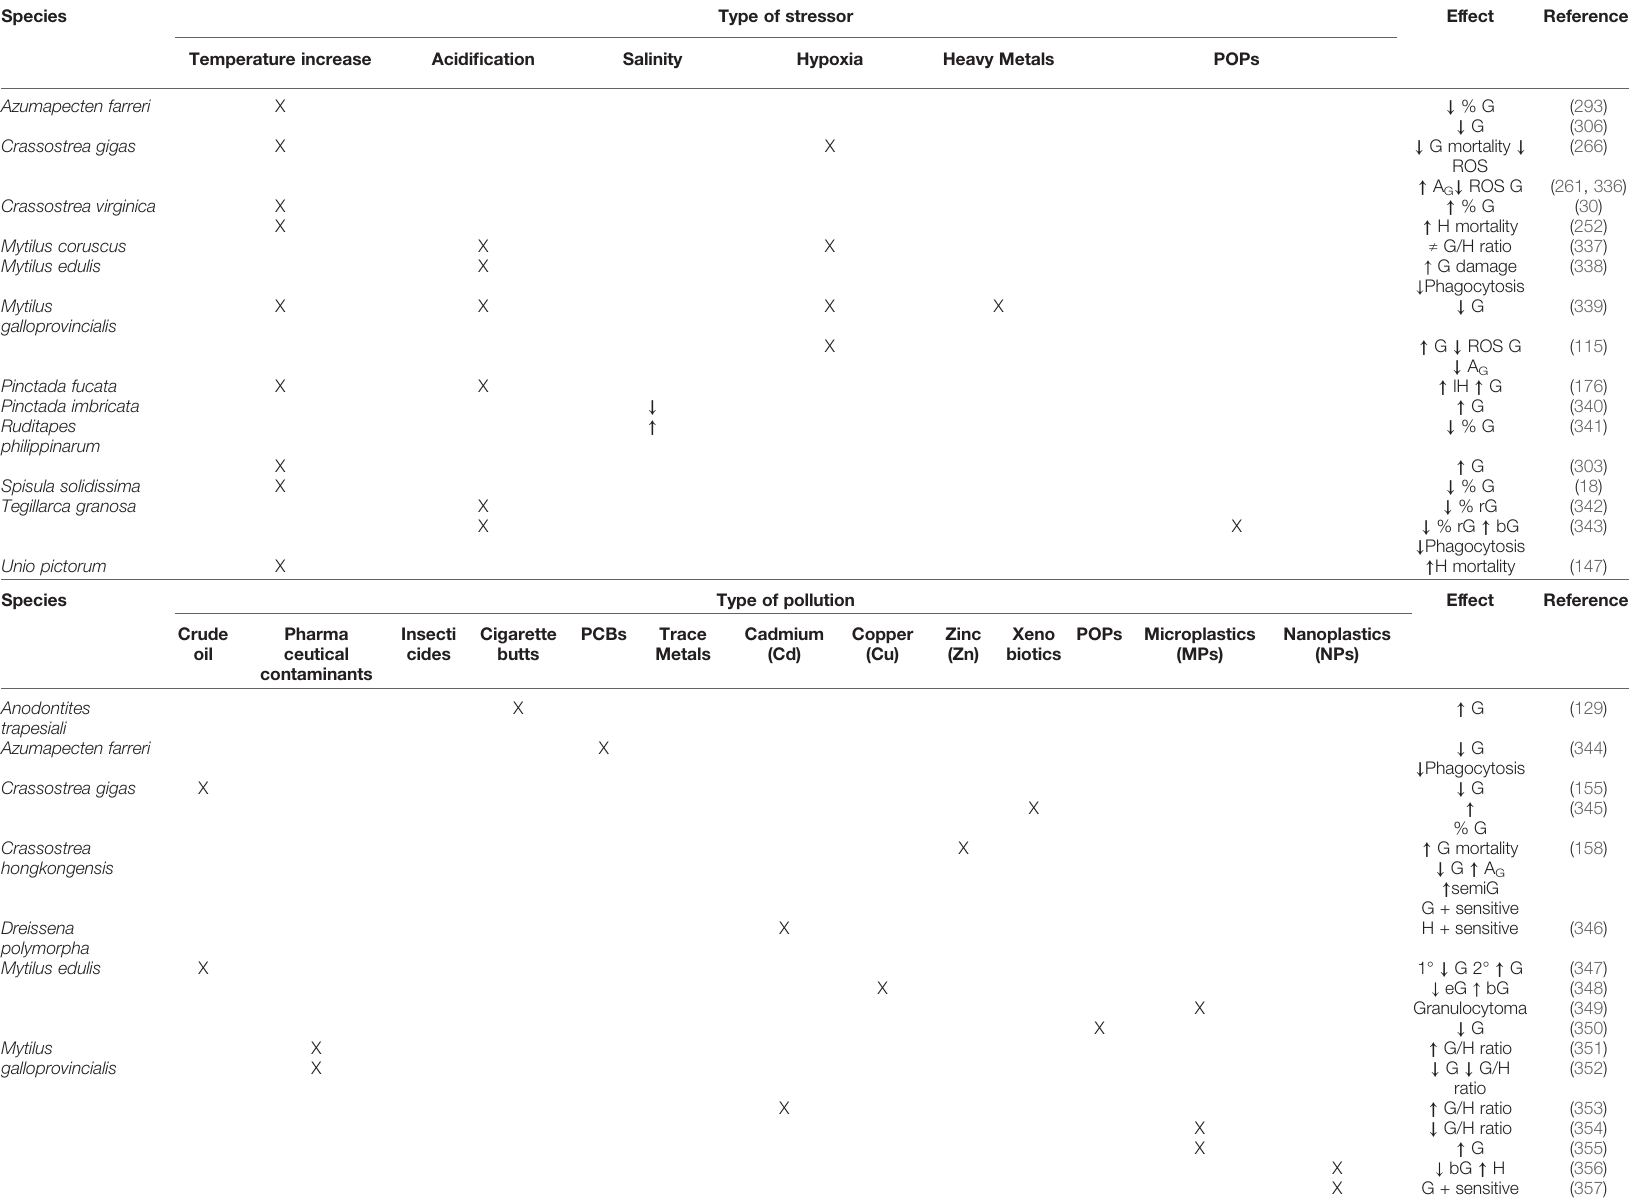
TABLE 3 | Literature survey of reported effects of abiotic stress on bivalve haemocyte subpopulations.